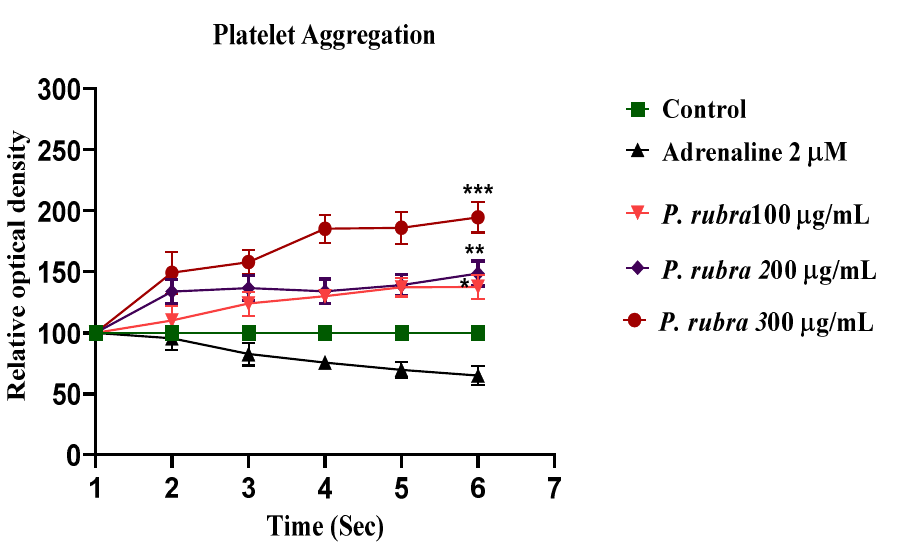
Figure 8. Anti-aggregatory effect of aqueous-methanolic leaf extract of P. rubra against ADR-induced aggregation on human platelet. All three doses of P. rubra showed significant anti-aggregatory potential in a dose-dependent fashion ( n = 5).